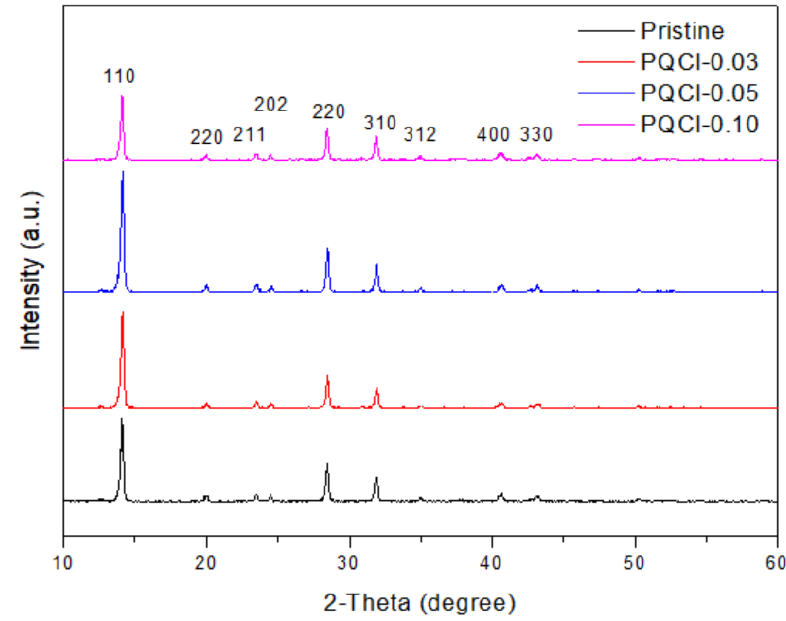
Figure 8. XRD patterns of MAPbI 3 films deposited on PQCl-modified NiO x